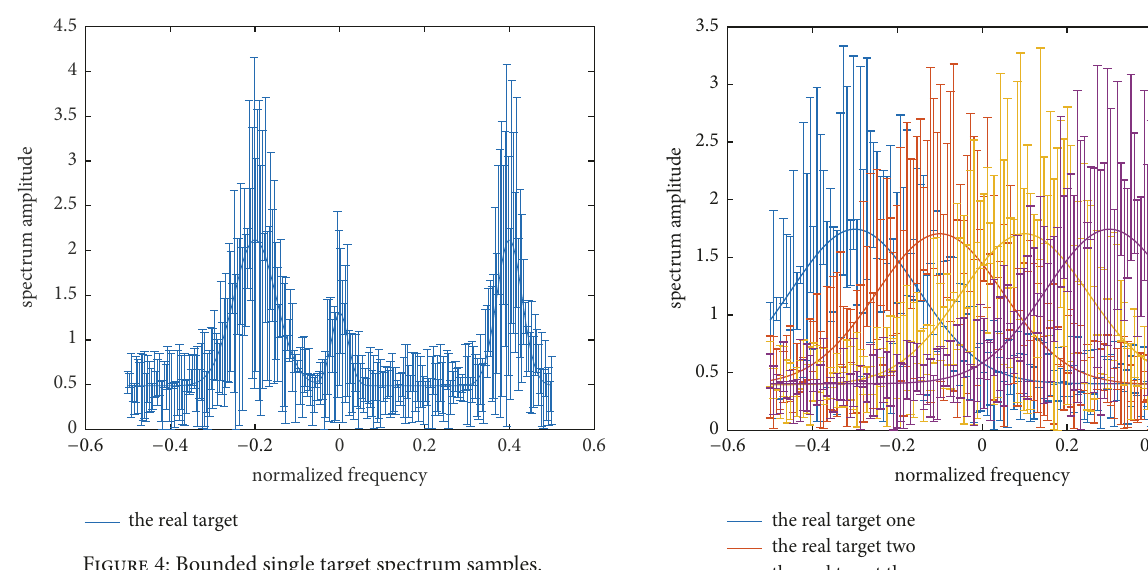
Figure 4: Bounded single target spectrum samples.